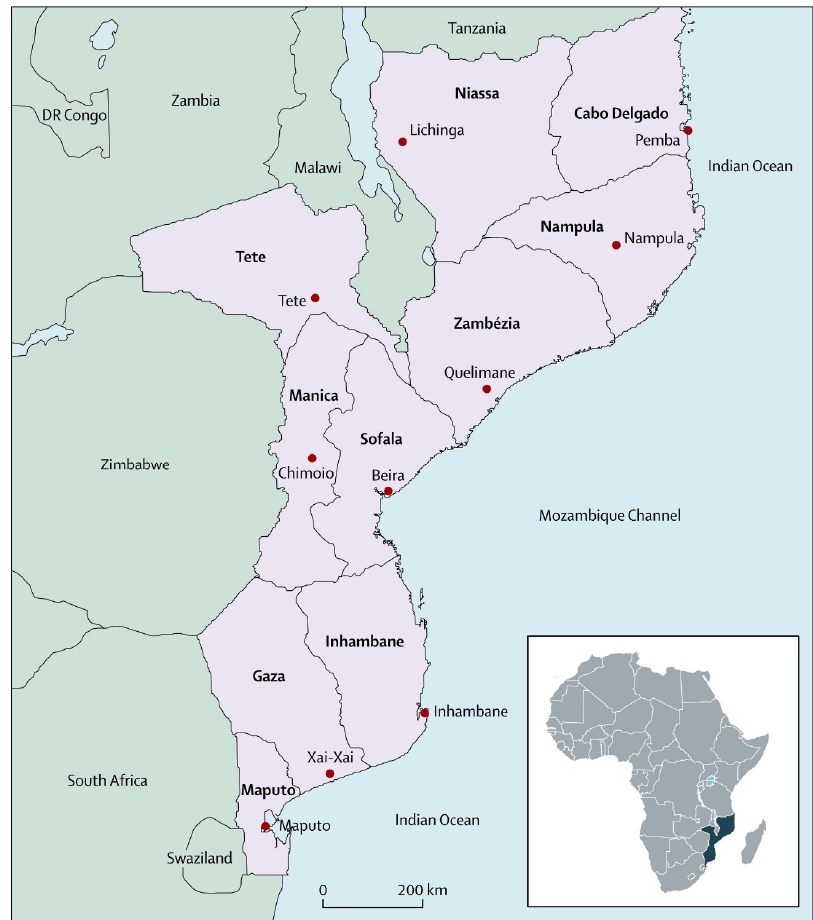
Figure 1. Map of Mozambique showing the province and province capitals.